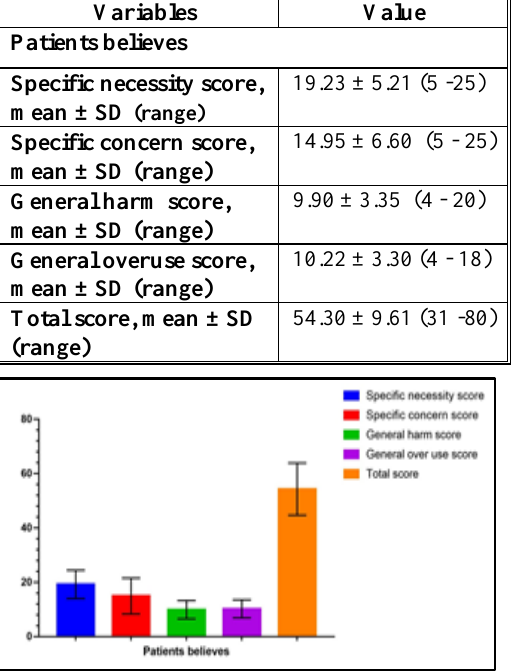
Figure 1. Belief about medications for all patients